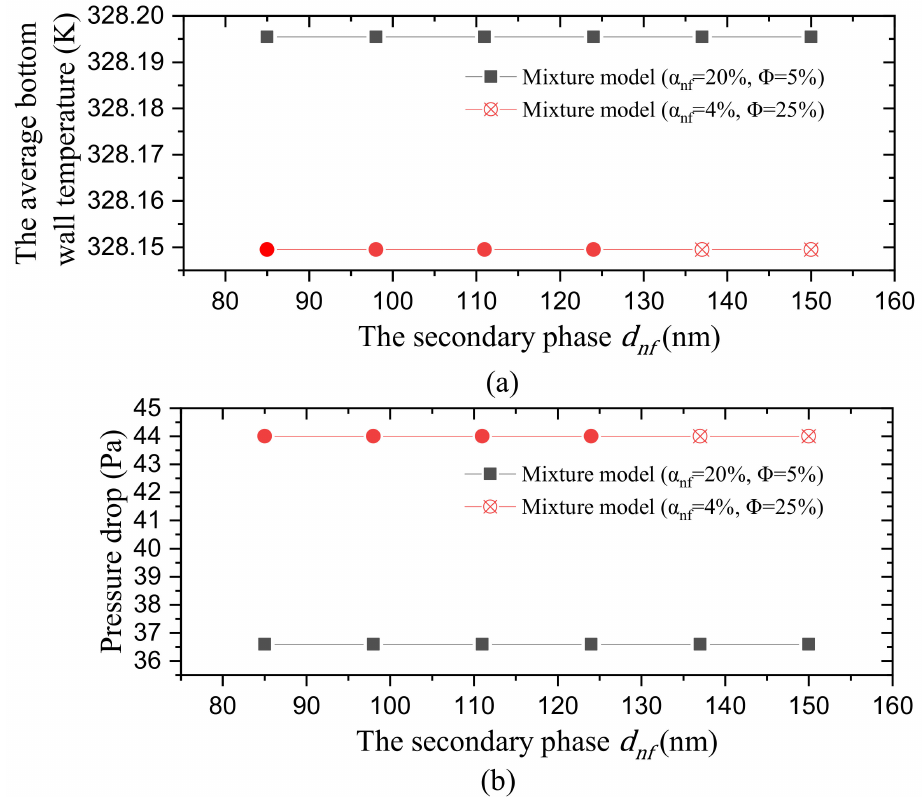
Figure 11. Variation of the minichannel ( a ) average bottom wall temperature and ( b ) inlet to outlet pressure drop with the phase two bubble diameter d nf , over the range 85 nm ≤ d nf ≤ 150 nm. Two-phase mixture model with second phase volume fractions α nf 20% and